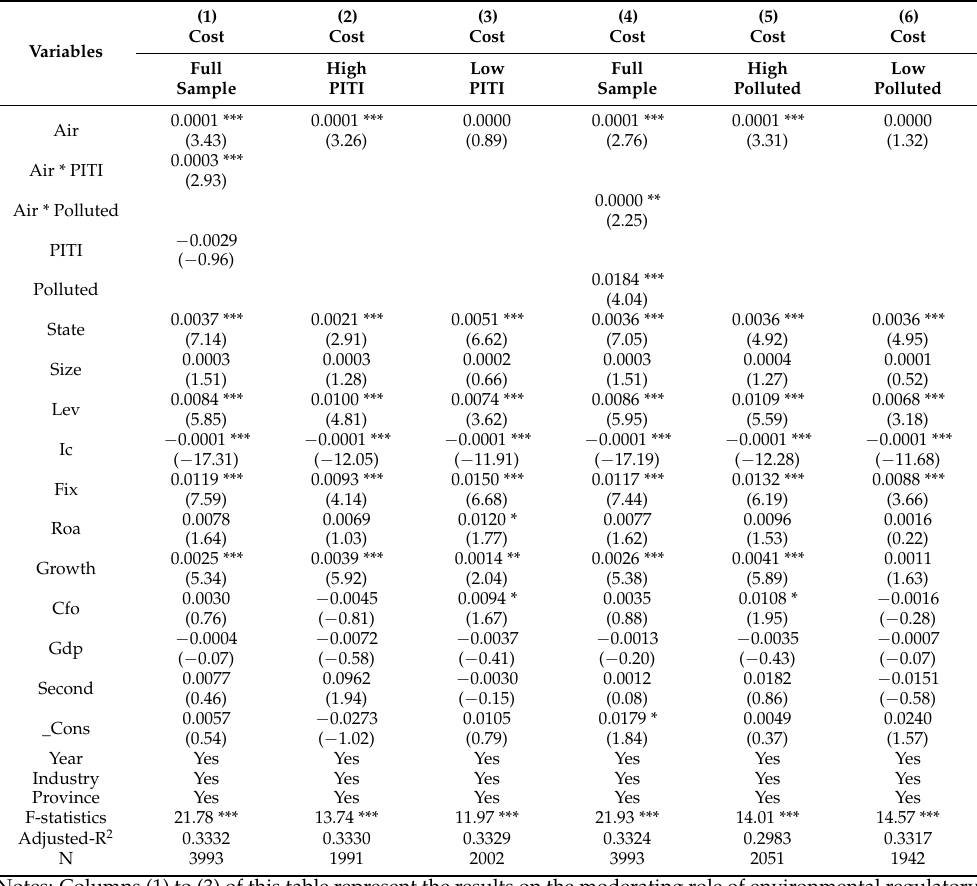
Table 11. Moderating effect of firm’s environmental regulatory pressure and industry